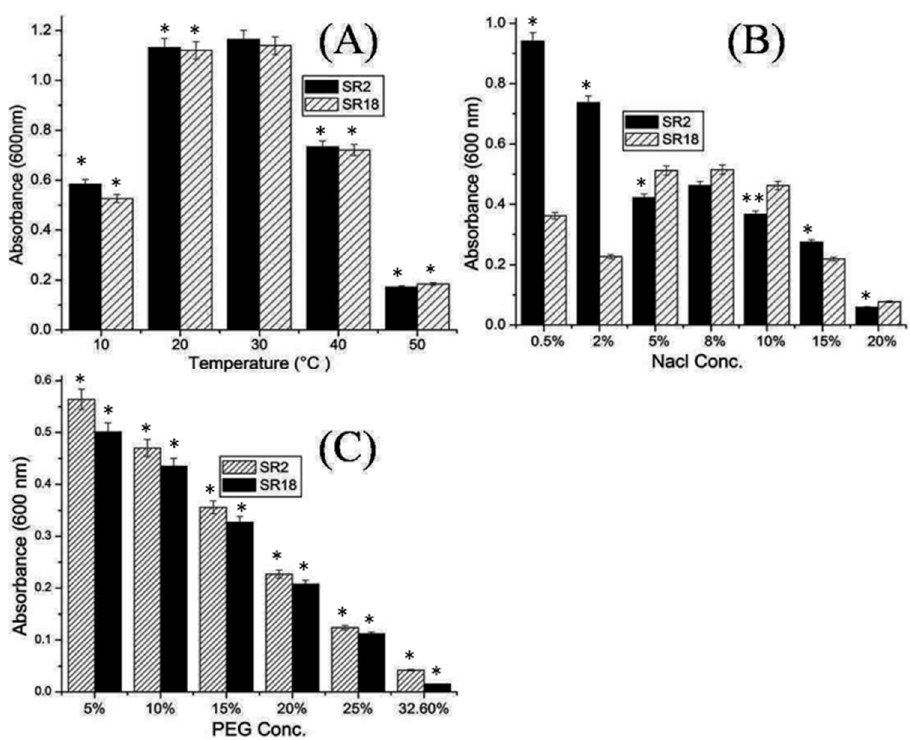
Figure 2. Abiotic stress tolerance activities of potential Bacillus strains SR2 ( Bacillus licheniformis ) and SR18 ( Bacillus velezensis ) ( A ) Temperature (10 to 50 °C) ( B ) Salinity Nacl (0.5 to 20%) ( C ) Drought PEG (5 to 32.6%). Experimental data are averages of three replicates. Bars display mean ± SE and statistical analysis was performed using a one ‐ way ANOVA with a Tukey post hoc test. Differences between means were considered to be significant if the calculated p ‐ values were p < 0.05 ** and p < 0.01 *. Table 4. Effect of single inoculation and coinoculation of Bacillus strains on different growth parame- ters of rice plants under greenhouse